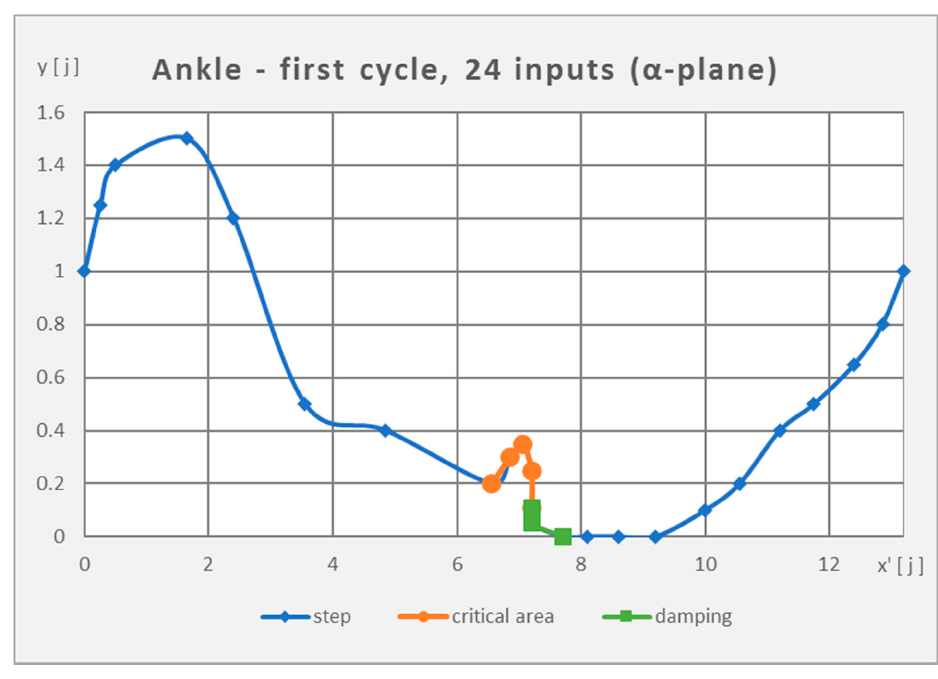
Figure 2. Ankle trajectory (the first step).